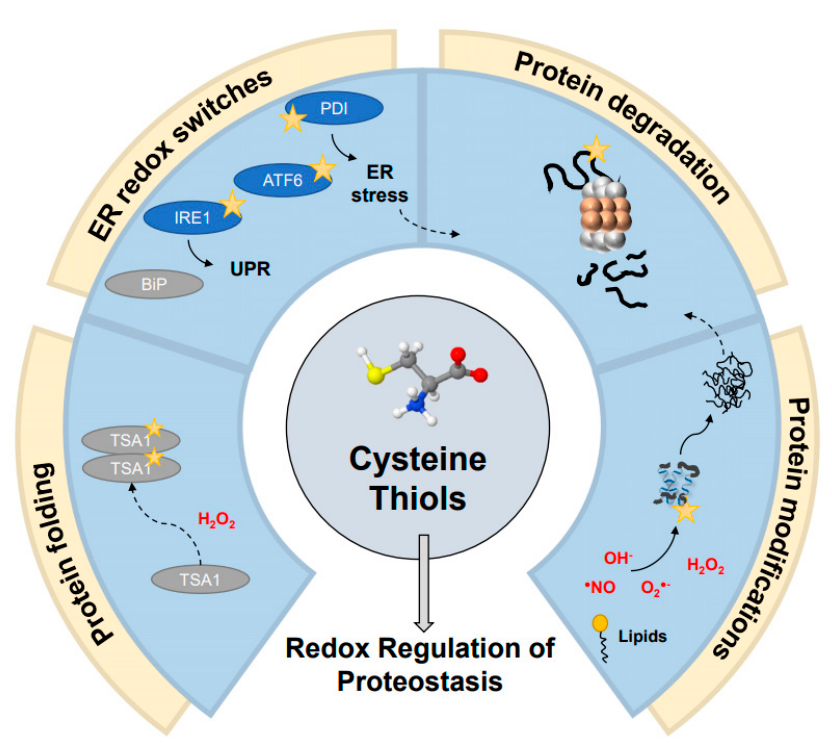
Figure 2. Redox switches in proteostasis. Cysteine thiol switches are involved in regulating various aspects of proteostasis, such as protein folding, ER quality control and the unfolded protein response (UPR), protein degradation across various stages, and protein modifications and maturation. Numerous examples of redox-sensitive thiols have been found across each of these stages of protein quality control, such as redox regulation of the peroxiredoxin TSA1, the ER protein disulfide isomerase (PDI) and BiP chaperones, members of the UPR mechanism IRE1 and ATF6, and the proteasome itself. These emerge from oxidative modifications of varying sorts, including reactive oxygen species (ROS), reactive nitrogen species (RNS), and lipid modifications. Table 1. Table summarizing select chaperones involved in maintaining protein homeostasis through redox